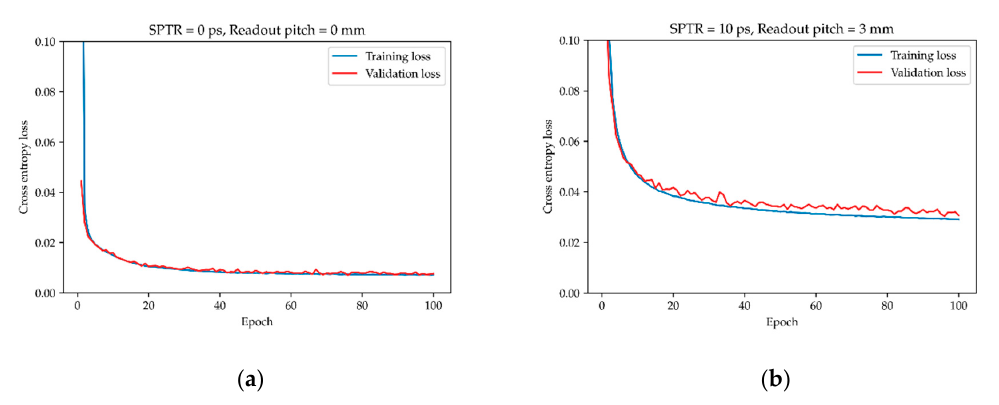
Figure 3. Training and validation loss curves at an ( a ) single photon time resolution (SPTR) of 0 ps and readout pitch of 0 mm, and ( b ) SPTR of 10 ps and readout pitch of 3 mm, respectively.